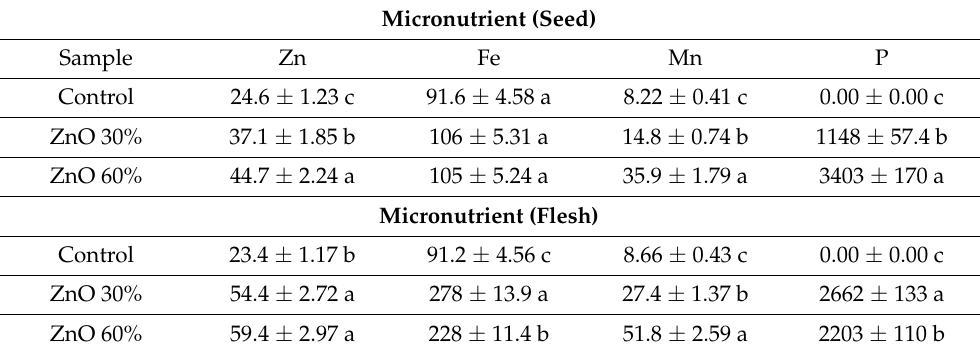
Table 1. Average content ( n = 3) of Zn, Fe, Mn and P (ppm) in grape flesh and seeds (after dehydration) in Fern ã o Pires grapes at harvest and the respective degree of uncertainty. Letters a, b, c indicate significant differences between treatments ( p < 0.05). Treatments ZnO with concentrations of 0%, 30%, 60%. (i.e., 0, 450 and 900 g ha − 1 ).